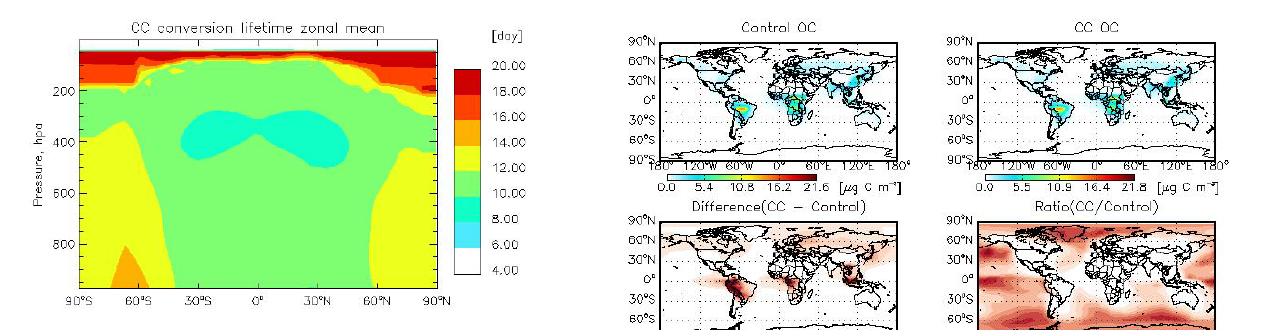
Fig. 4b. Zonal mean plot for hydrophobic to hydrophilic conver- sion lifetime for carbonaceous aerosol by condensation-coagulation aging scheme.